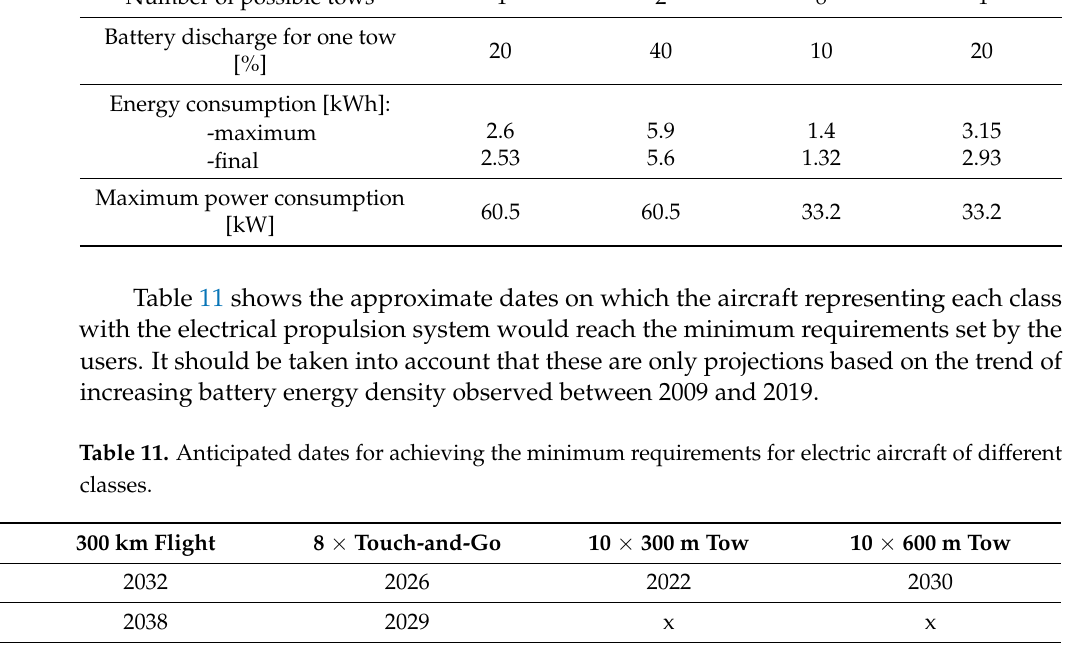
Table 10. Comparison between PZL-101 Gawron and WT-9 Dynamic—glider tugs. Parameter PZL-101 Gawron WT-9 Dynamic Height of tow 300 600 300 600 Number of possible tows Battery discharge for one tow [%]